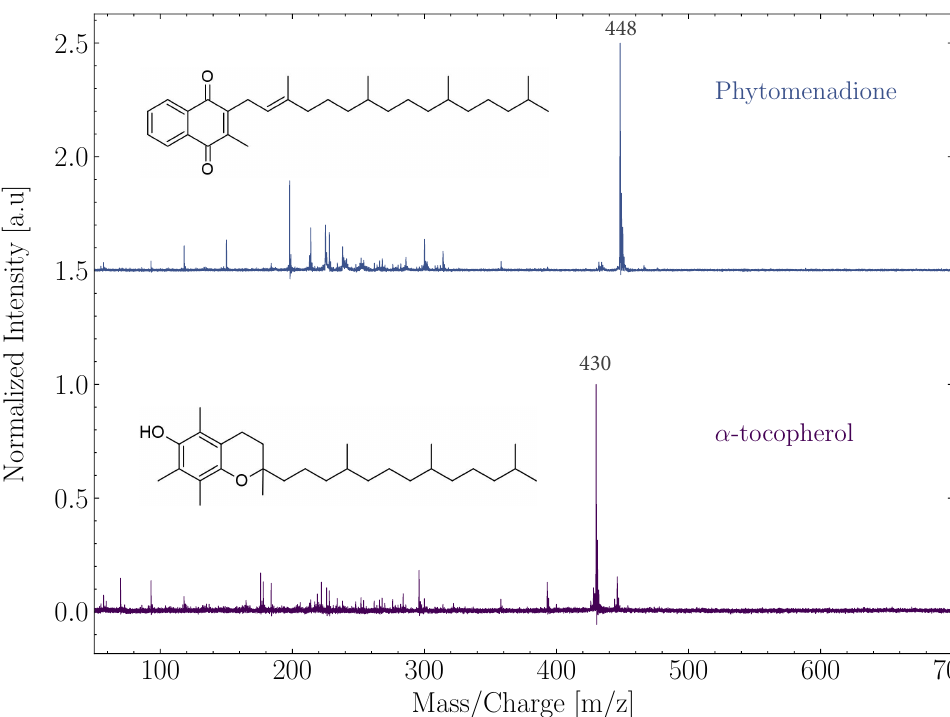
Figure 2. Normalized spectra of the lipids phytomenadione and α -tocopherol. The structure of the respective lipids was added to the left and prominent mass peaks are indicated. The spectra were offset from each